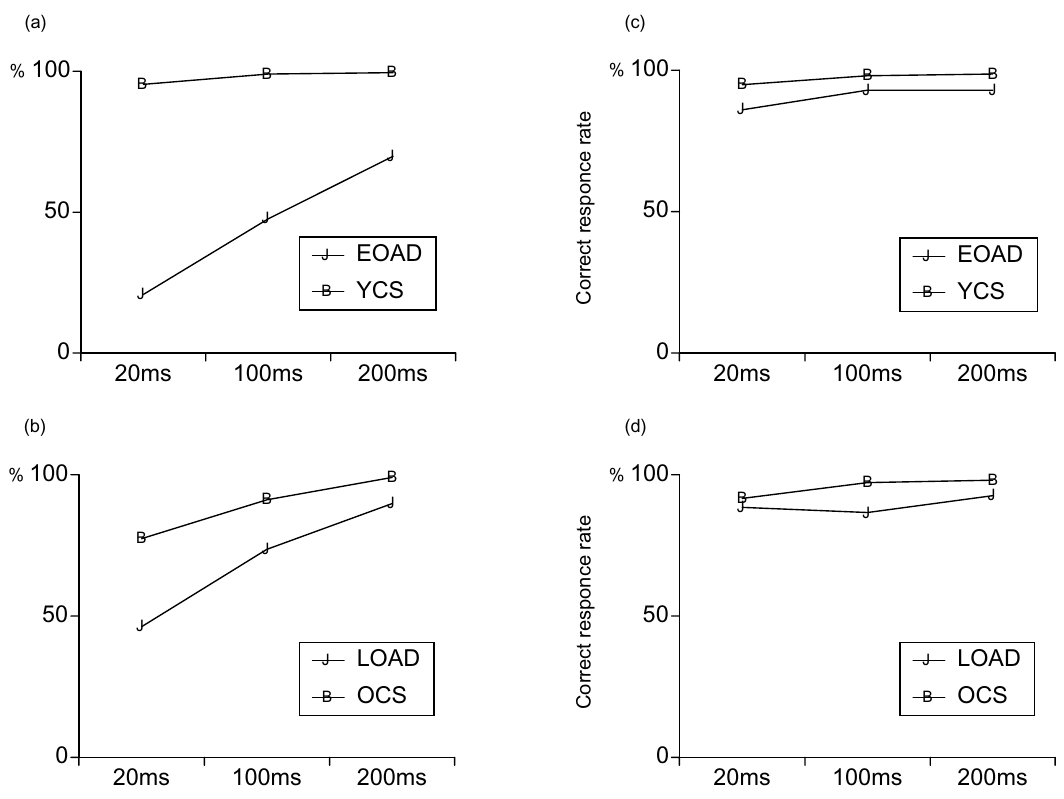
Fig. 2. Mean percentage of correct response to global and local targets as a function of the exposure duration for early onset Alzheimer’s disease patients (EOAD), late onset Alzheimer’s disease patients (LOAD), younger control subjects (YCS) and older control subjects (OCS). Fig. 2(a) showed response to global targets in EOAD and YC S. Fig. 2(b) showed response to global targets in LOAD and OCS. Fig. 2(c) showed response to local targets in EOAD and YCS. Fig. 2(d) showed response to local targets in LOAD and